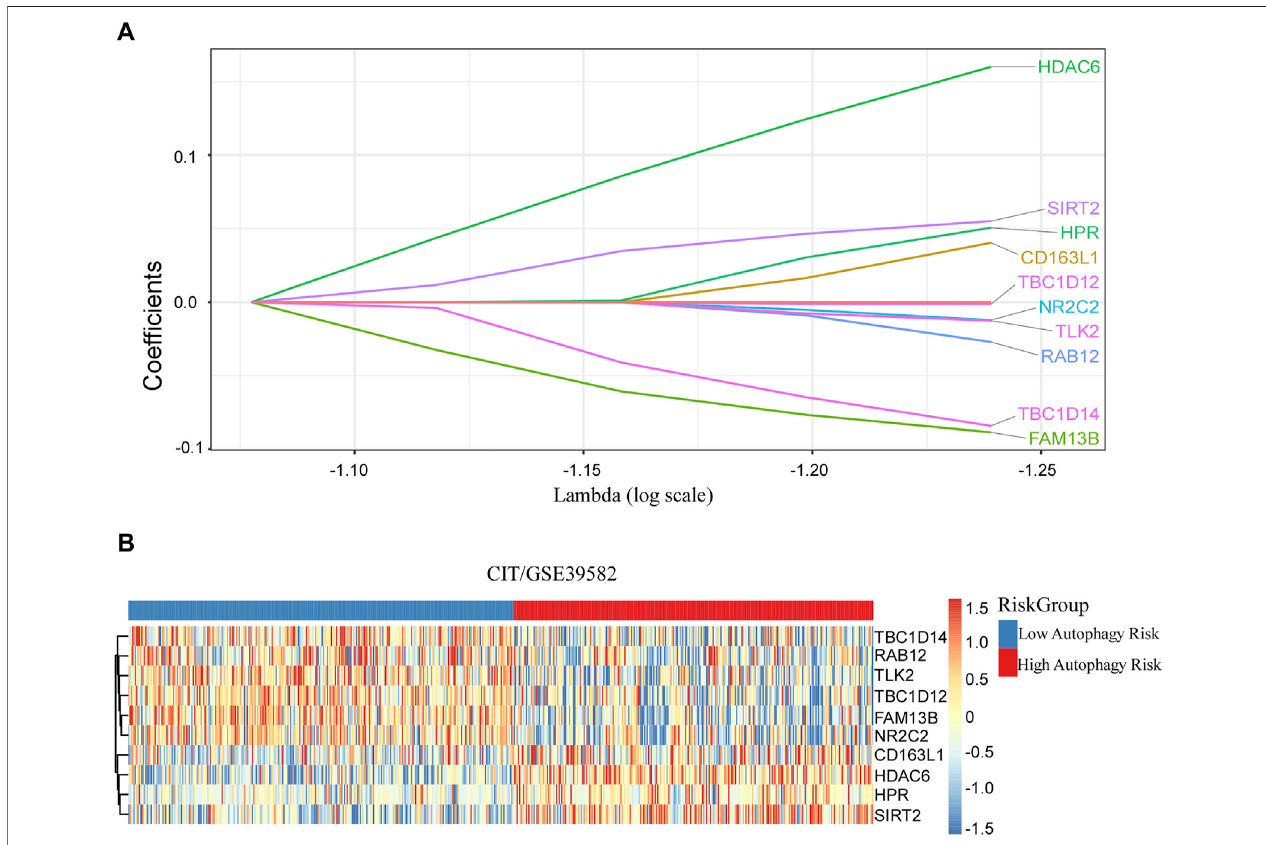
FIGURE 2 | Discovered ATG signature for prognostic prediction of colorectal cancer. (A) Ten ATGs signatures were found from the LASSO Cox regression. (B) Heatmap of the identi fi ed 10-gene signature.